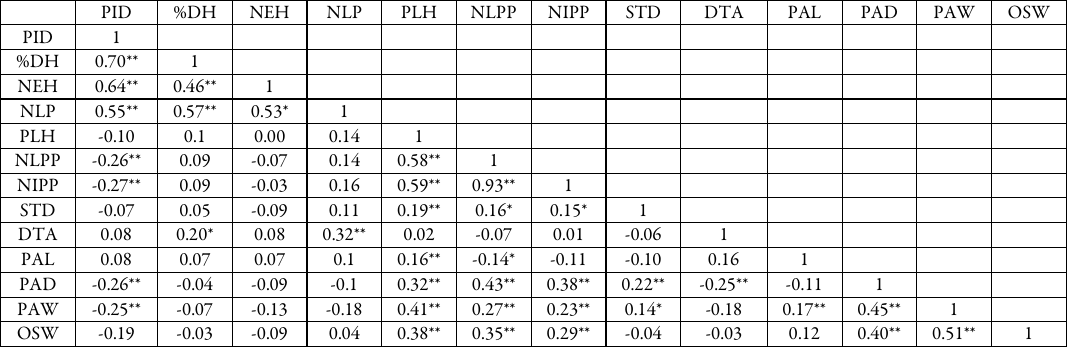
Table 5. Pearson correlation of disease and insect indices with morphological parameters in pearl millet germplasm